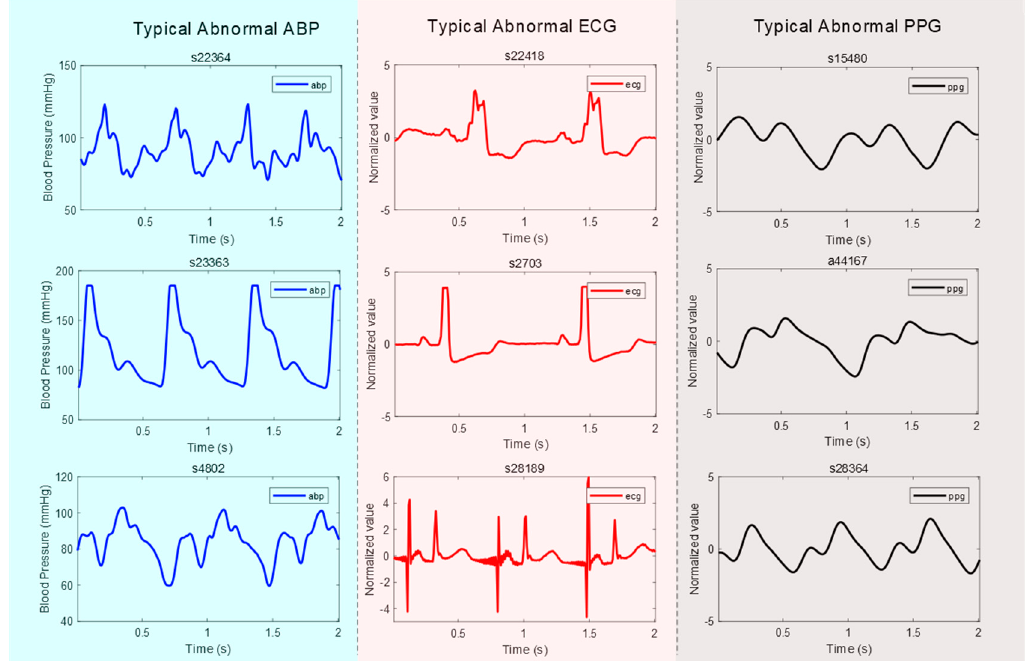
Figure 1. Annotations and typical cases of abnormal waveforms that were excluded from this study. Note that ABP is the arterial blood pressure, ECG is the electrocardiogram, and PPG is the photoplethysmogram signal.